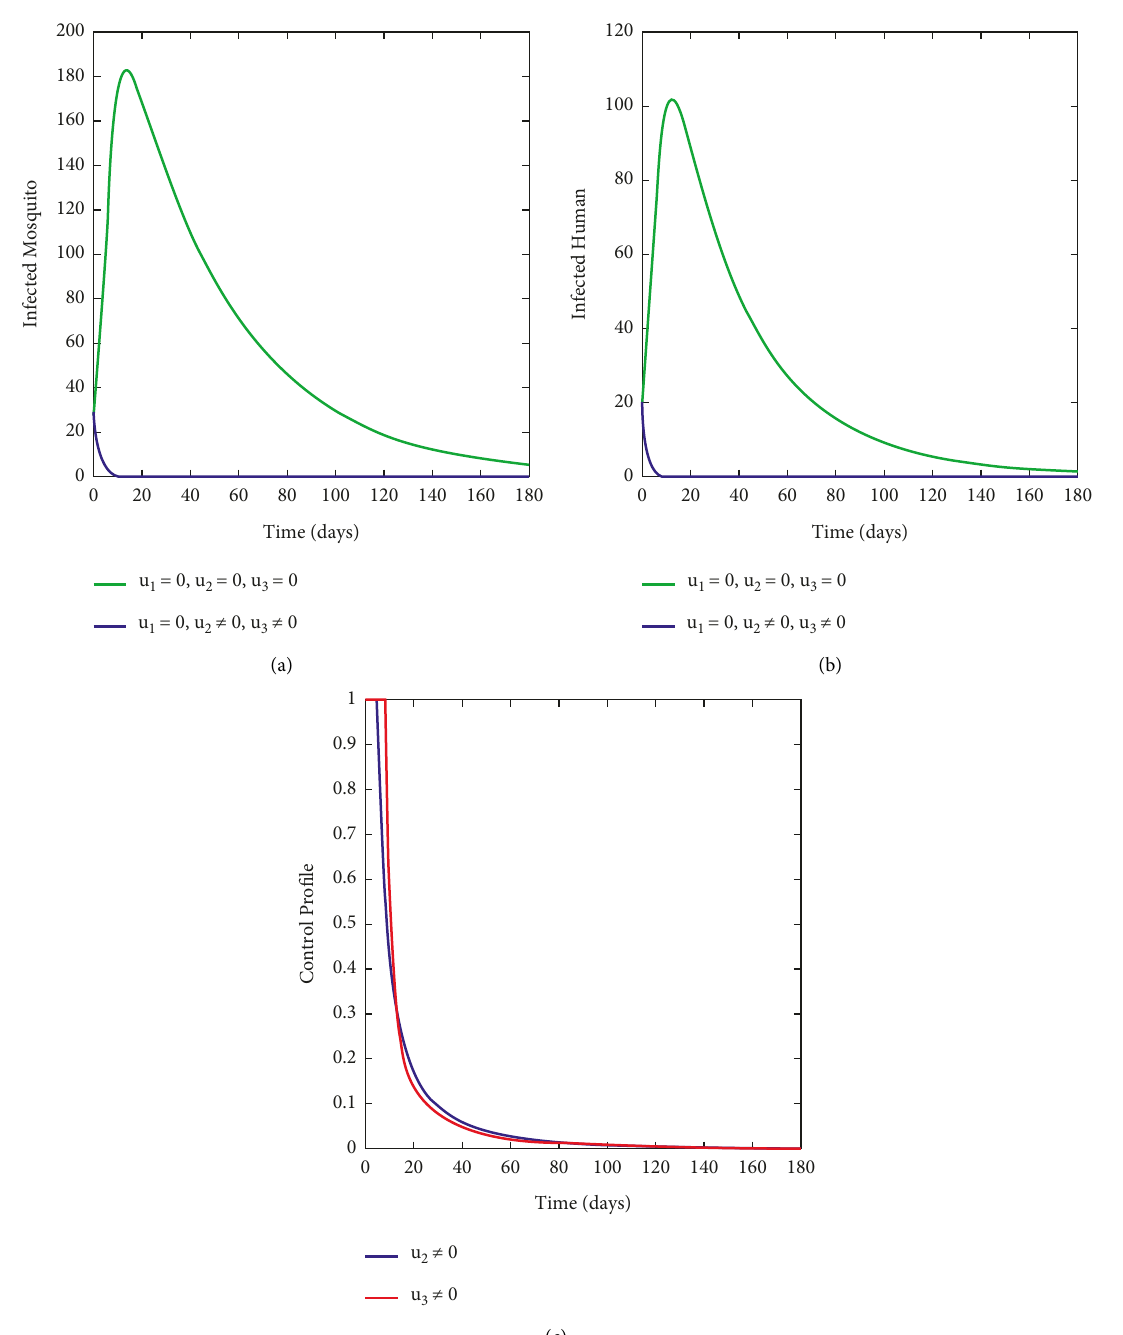
Figure 4: Simulation results representing (a) treatment of malaria infectious ( u , u ≠ profile for u 2 3